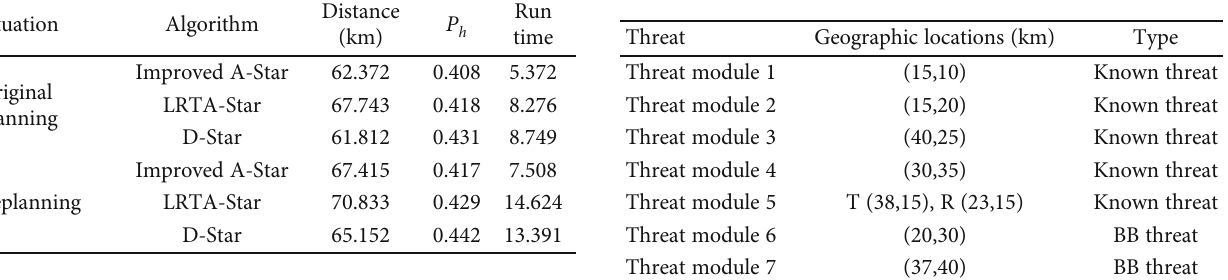
Figure 7: The detection probability of netted radar in the fi rst threat scenario. Table 3: The statistical result of fl ight in the fi rst scenario. Table 4: The geographical location and types of threat sources in the second threat